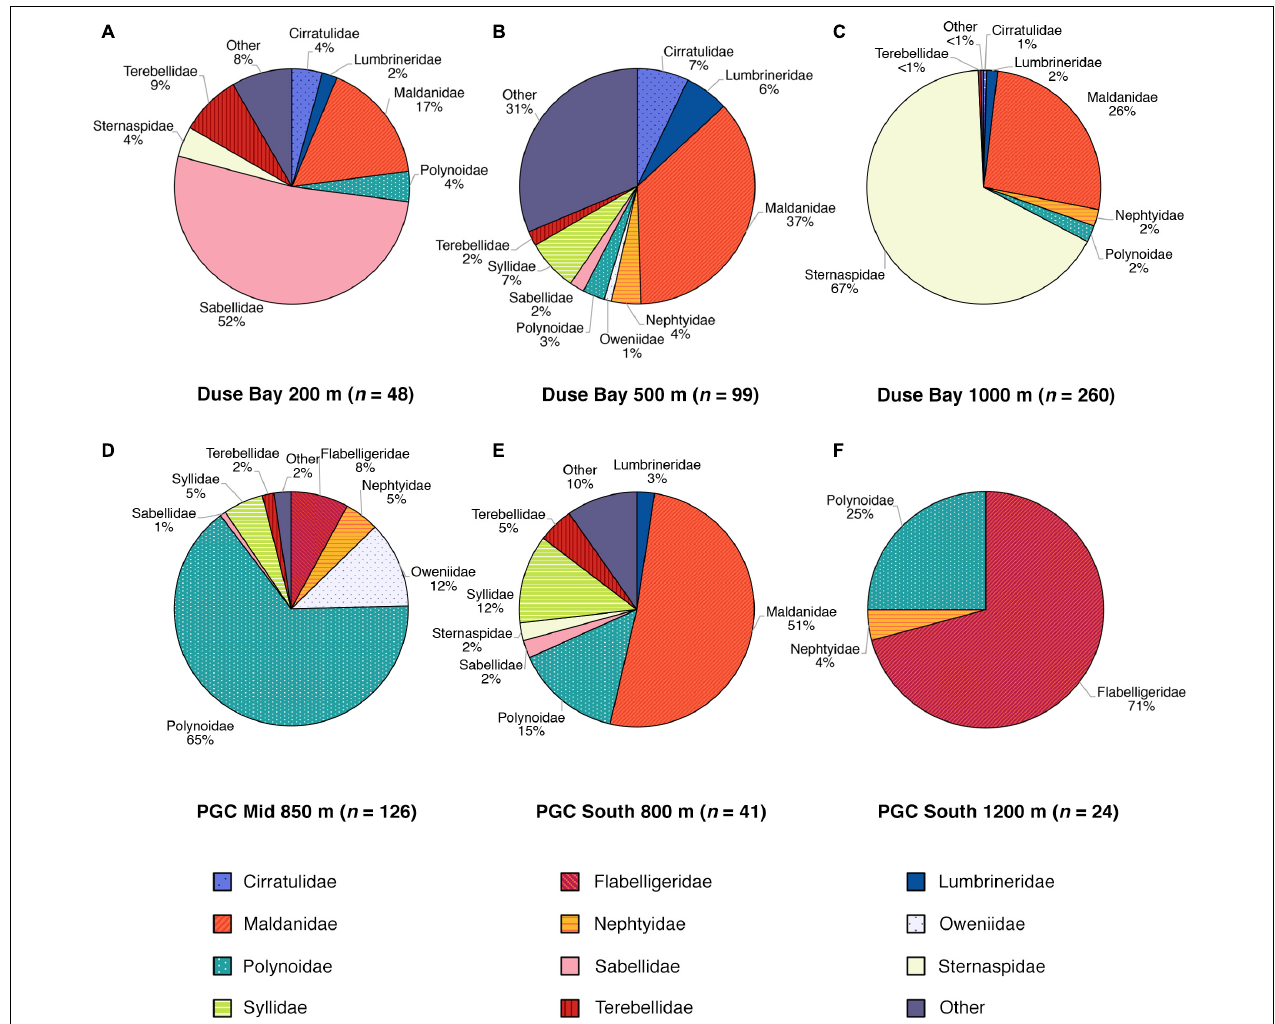
FIGURE 5 | Proportions of total specimen abundance by annelid family for each Agassiz Trawl sample site. (A) Duse Bay 200 m (B) Duse Bay 500 m (C) Duse Bay 1000 m (D) PGC Mid 850 m (E) PGC South 800 m (F) PGC South 1200 m. Families that had less than ten individuals across all sites (14 out of a total of 25 families) were combined into a single category,